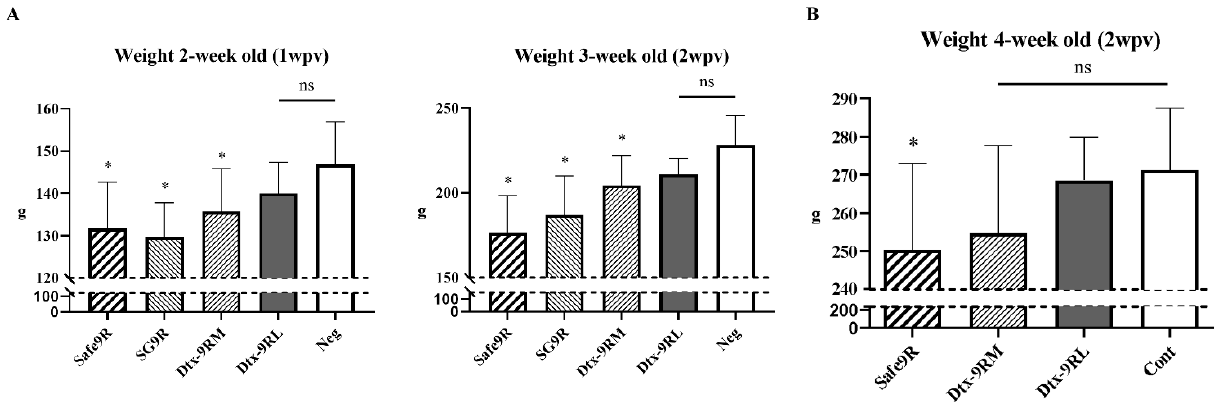
Figure 4. In vivo verification of detoxification by chick body weight model. Inactivated vaccines were inoculated in ( A ) 1 week-old and ( B ) 2 week-old chicks and the differences in body weight were examined. The significance was compared to the negative control. Statistical significance indicated as follows: ns not significant, * significantly different compared with Neg ( p < 0.05).